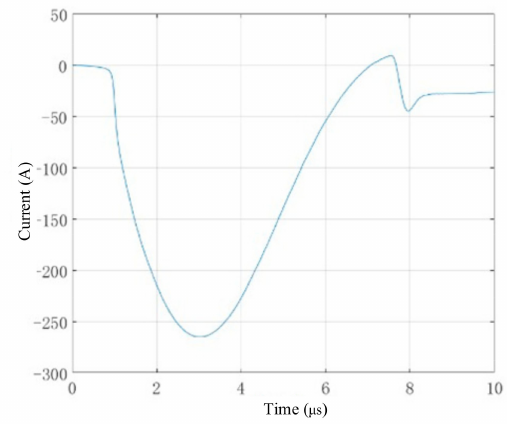
Figure 3. The current source through exciting coils in the experiments.